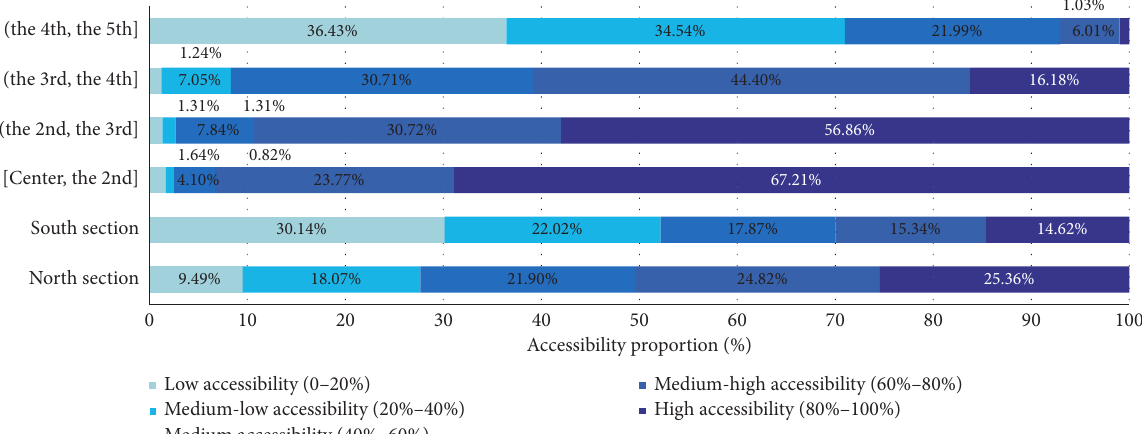
Figure 8: Spatial disparity in subregions. The accessibility is clustered into 5 categories and the proportion of each accessibility level is calculated.